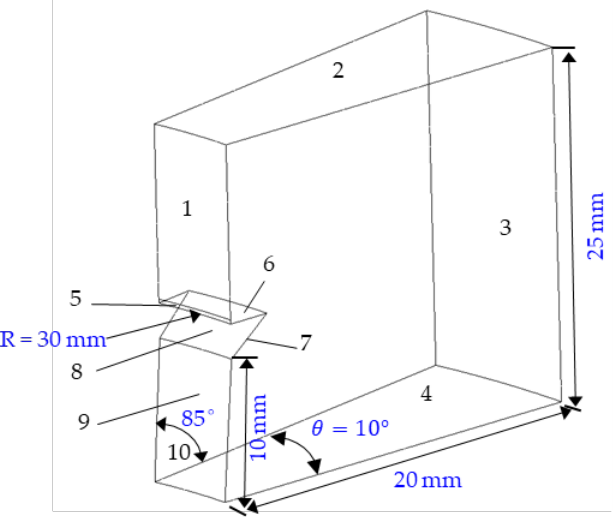
Figure 1. Two-dimensional schematic illustration of computation domains defined in 2D and 3D CFD models.